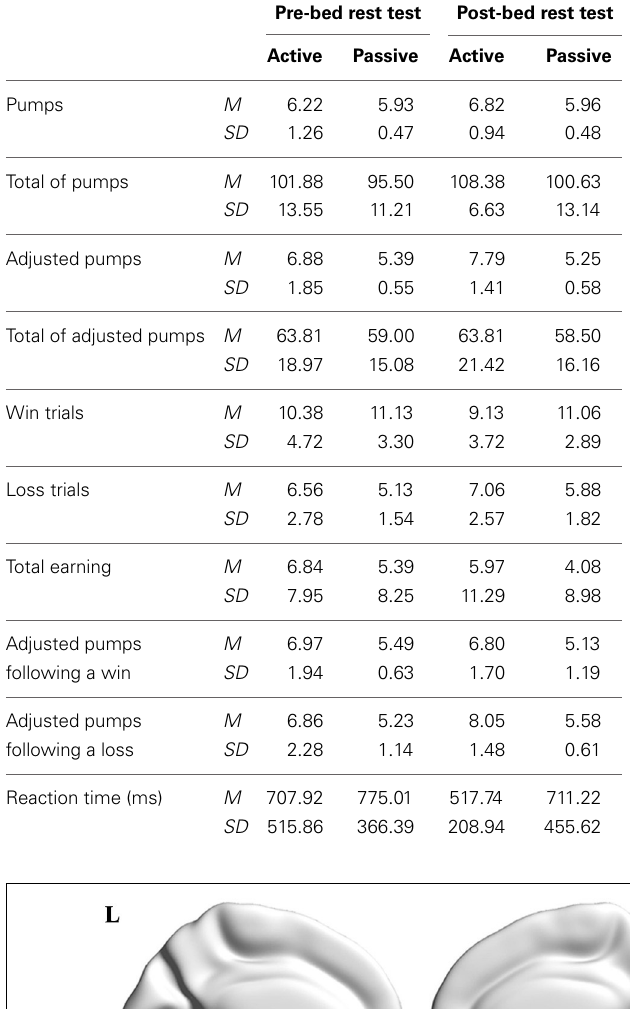
Table 2 | The behavioral results of the fMRI experiment.